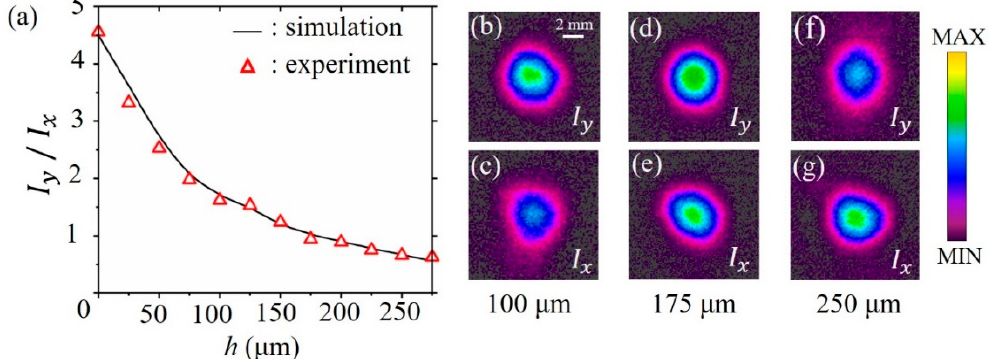
Figure 4. ( a ) Simulated and measured splitting ratios as functions of the PI thickness. ( b – g ) Measured field distributions of y - and x -polarized components for h = 100, 175, and 250 μ m, respectively. The experimental setup for measuring THz beam splitting is shown in Figure 5a.